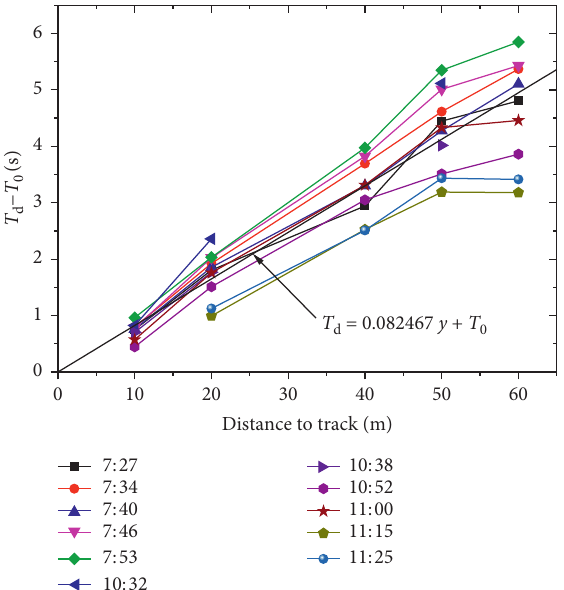
Figure 9: Fitting of duration increase with